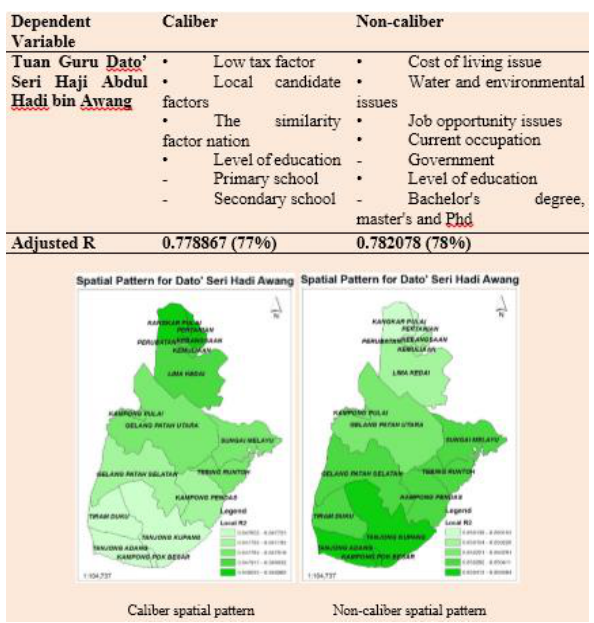
Figure 20. Explanatory variable for Dato‟ Seri Hadi